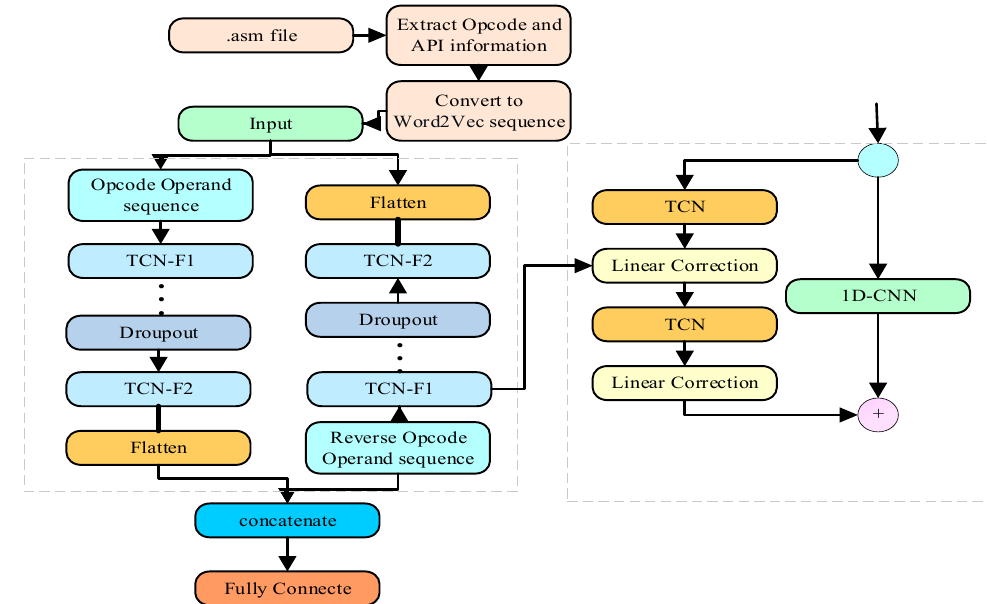
Figure 3. Multi-feature fusion BiTCN malware classification method.